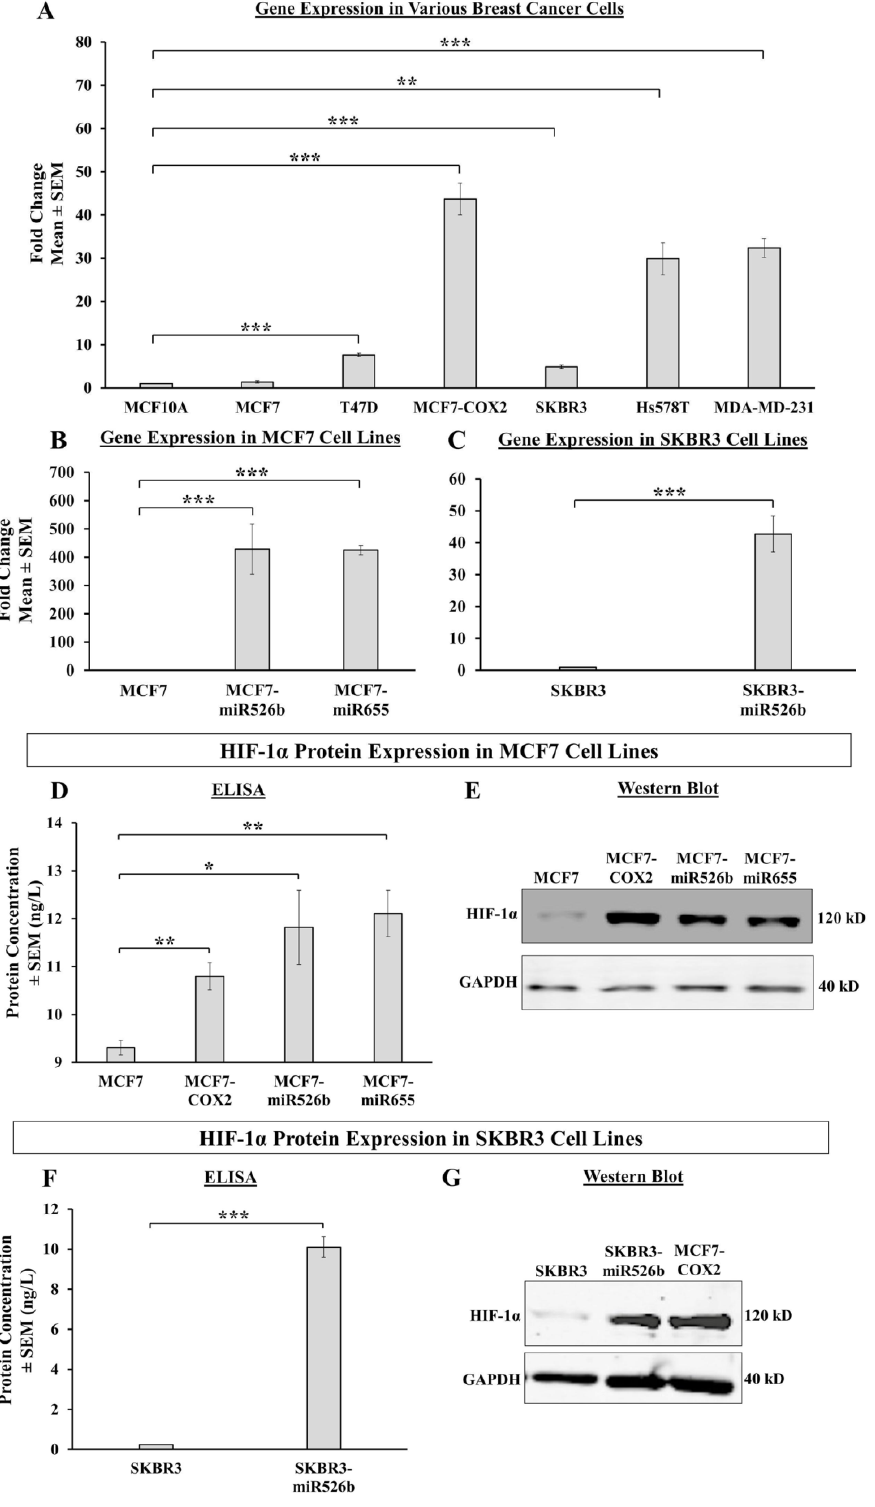
Figure 1. HIF-1 α mRNA and protein expression in various breast cancer cell lines in normoxic conditions: ( A ) HIF-1 α mRNA expression in various breast cancer cell lines (T47D, SKBR3, MCF7-COX2, Hs578T, and MDA-MB-231) in comparison to mammary epithelial cell line MCF10A. ( B , C ) HIF-1 α